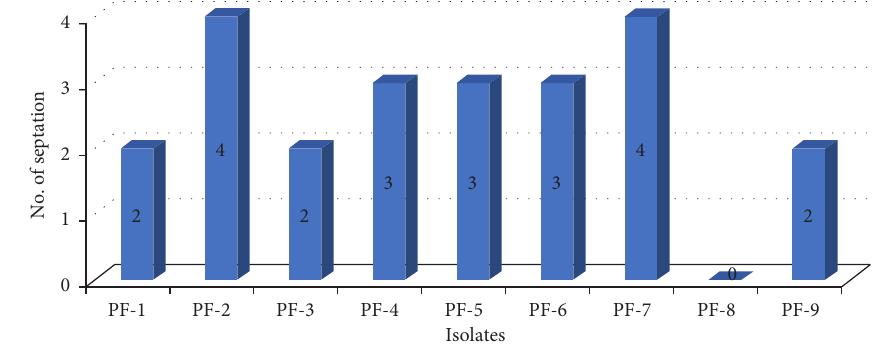
Figure 1: Fungal isolates with macroconidia septation number. Table 2: Morphological and biochemical characterization of isolated bacteria.